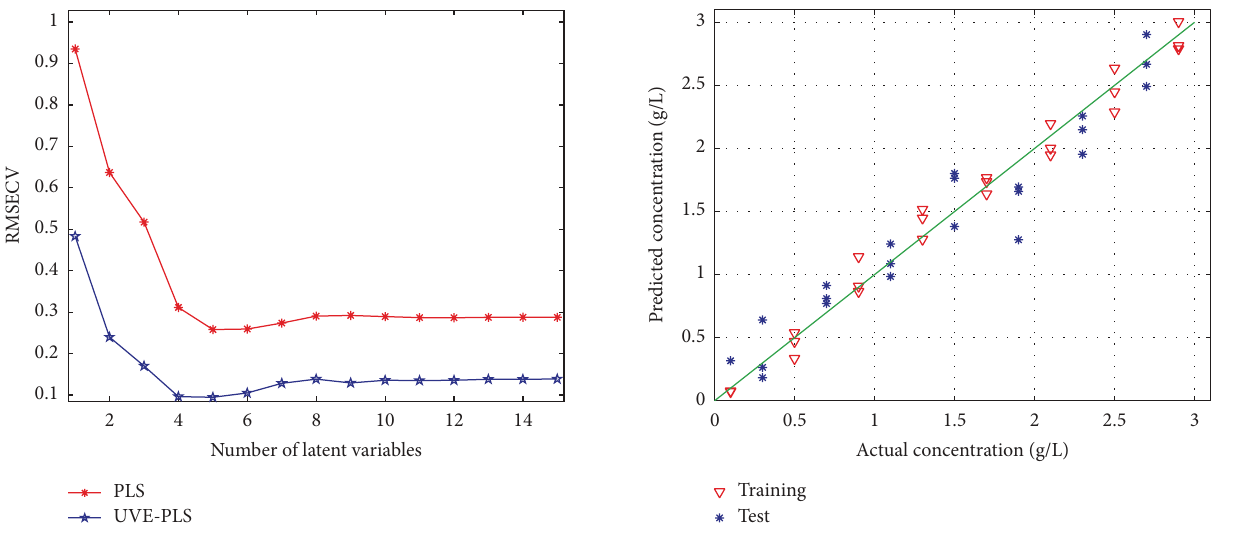
Figure 3: The RMSECV plot as a function versus the number of latent variables of PLS and UVE-PLS models.